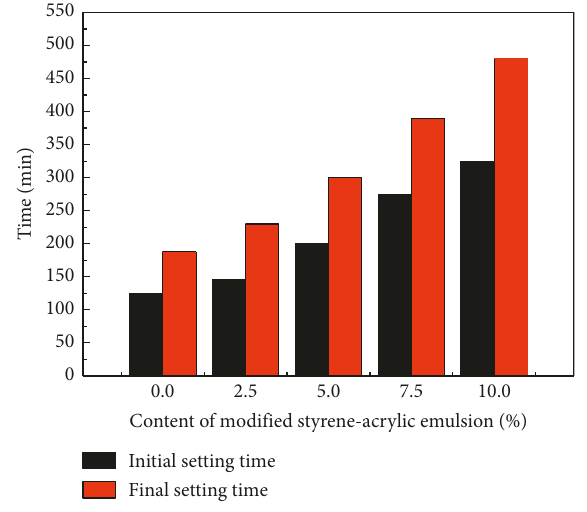
Figure 11: Influence of the emulsion content on the setting time of the cement